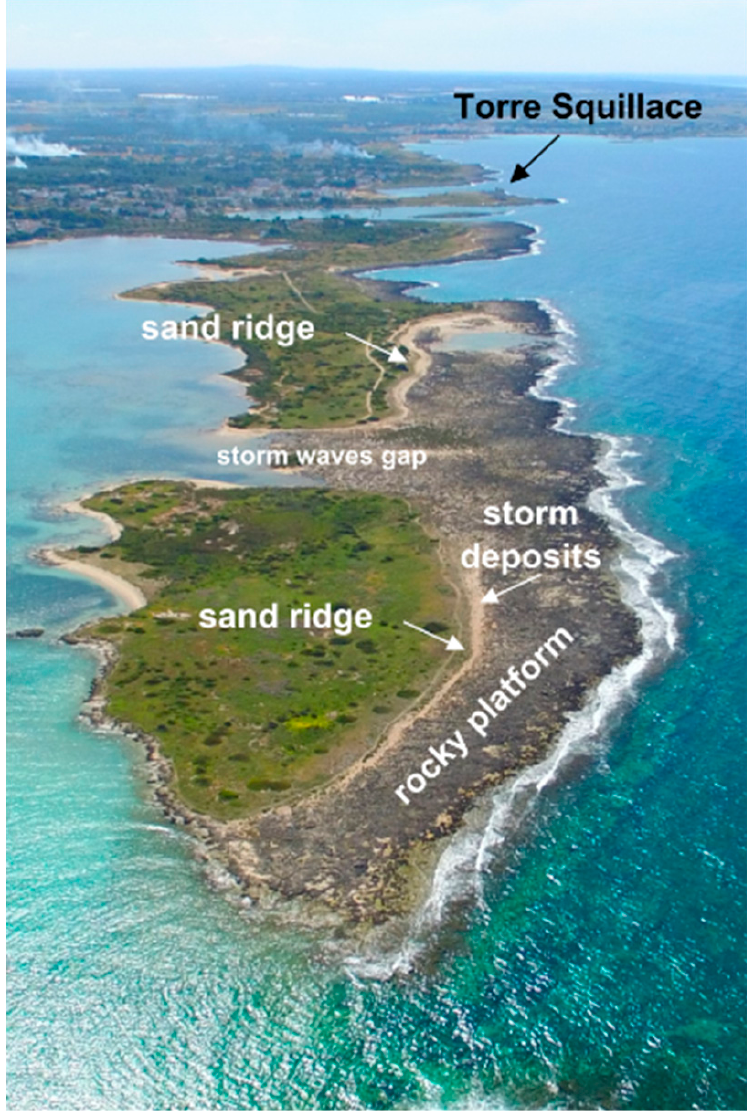
Figure 3. An aerial view of the La Strea site (Porto Cesareo municipality). The low-elevated rocky platform backed by the studied sand ridge is well visible. The surface of the rocky platform is actively washed by storm waves that produce an erosive gap through the sand ridge.